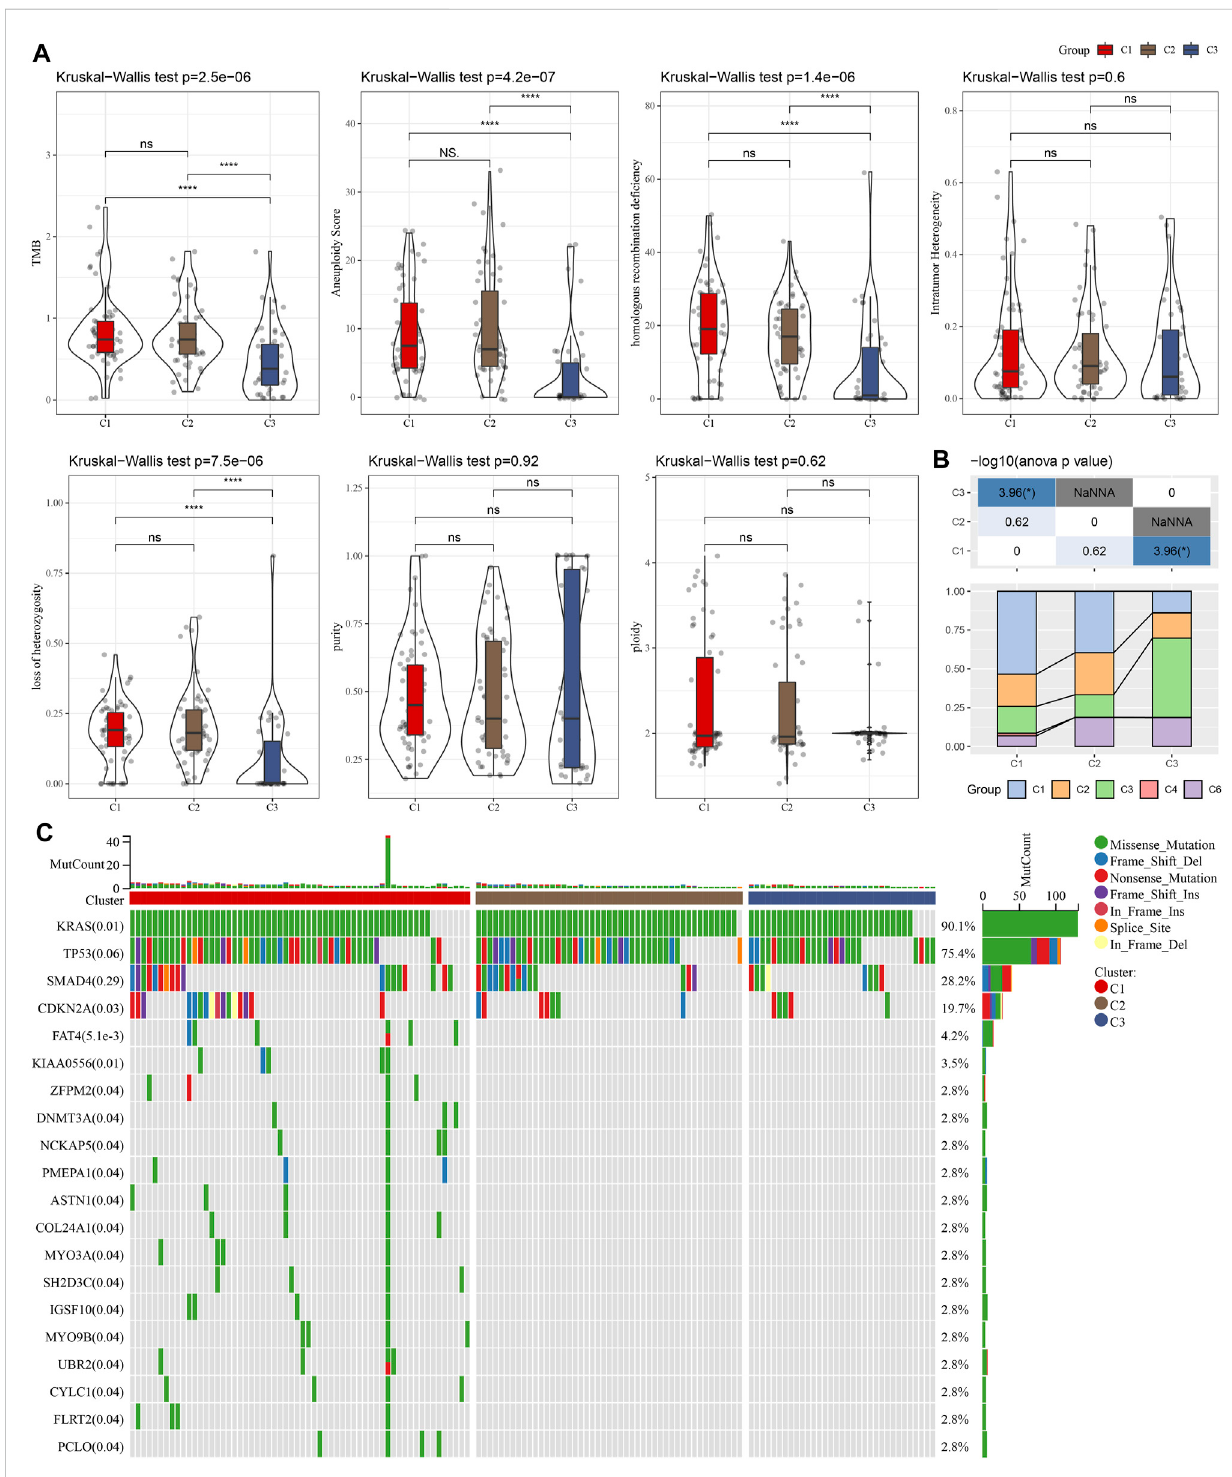
FIGURE 2 The comparison between our de fi ned cluster with other existing subtypes. (A) The comparison of our de fi ned clusters with the subtypes derived from the pan-cancer study. (B) The comparison of our de fi ned clusters with immune signature-derived subtypes. (C) The comparison of somatic mutations in NKGs-derived subtypes in the TCGA cohort. * p < 0.05; ** p < 0.01; *** p < 0.001; and **** p <